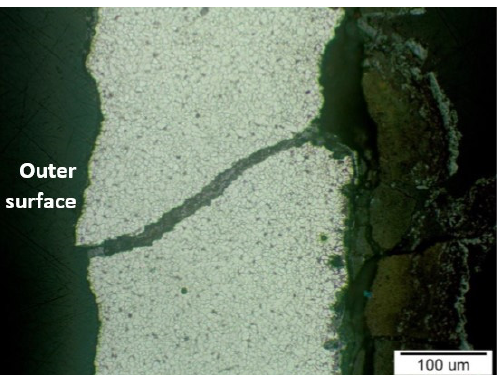
Figure 13. The development of the crack towards the inside of the material with the corrosion layer on the inner surface of the sample T3 (in Figure 10 is the observed area indicated by the yellow arrow); etch, Nital.